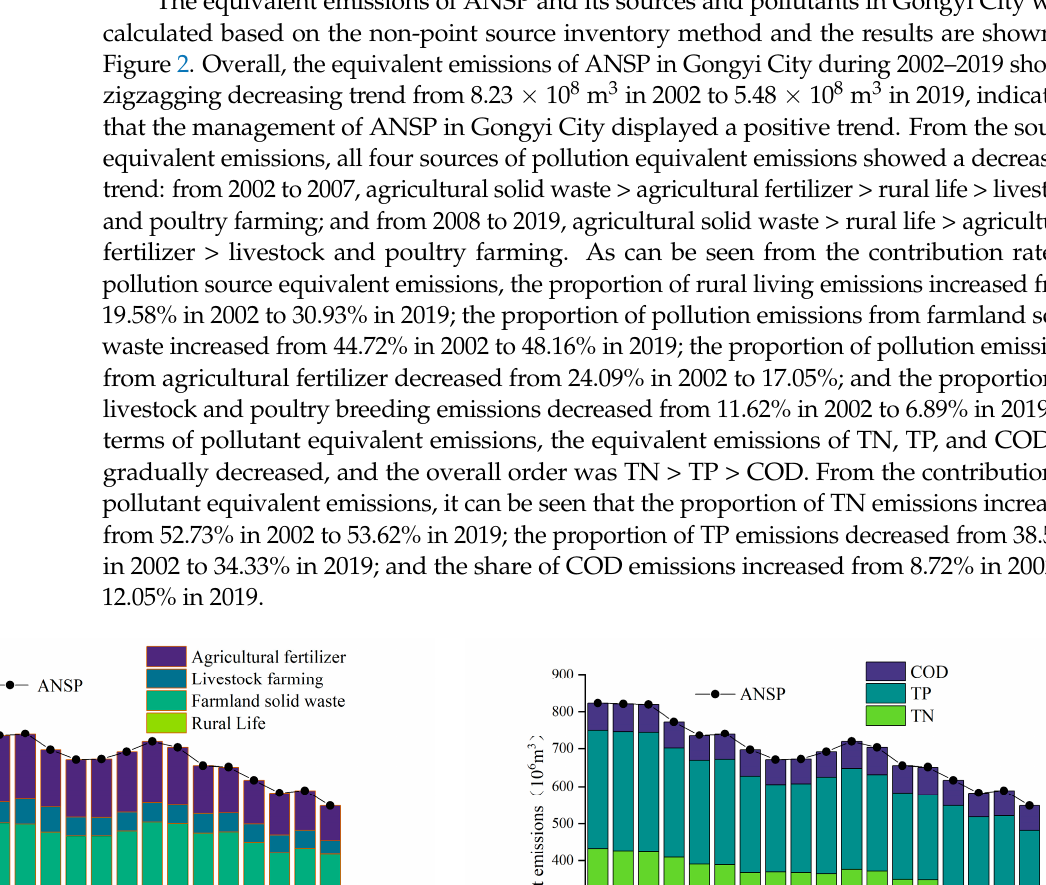
( b ) Figure 3. Spatial distribution of ANSP in Gongyi City: ( a ) 2002; ( b ) 2019. 3.1.3. Spatial Correlation Analysis of ANSP Stata 16.0 software was used to test the spatial correlation of ANSP equivalent emis- sions in 14 small town areas in Gongyi City from 2002 to 2019 (Table 3). The results show that Moran’s I index of ANSP equivalent emissions is significantly positive during the study period and the change trend also indicates Moran’s I index is increasing, demon- strating that ANSP in each township of Gongyi City is not randomly spatially distributed but has positive global spatial autocorrelation characteristics. Over time, the agglomera- tion gradually increased.